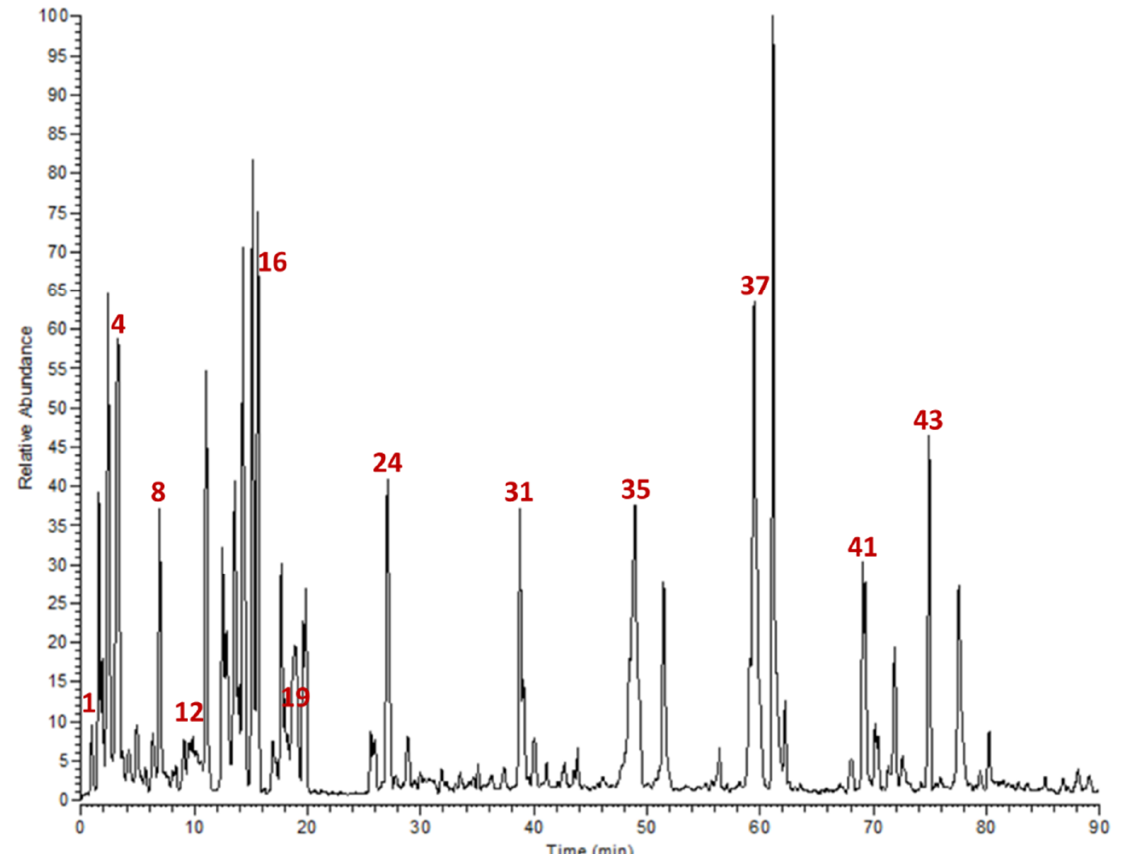
Figure 1. Base peak chromatogram of L. coronopifolia Poir. aerial parts’ extract.